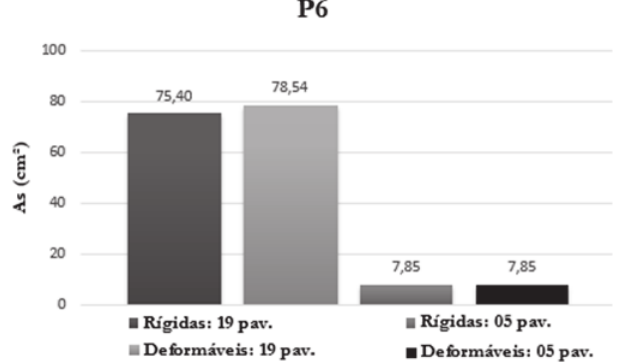
Figura 19 Modelo de Alva e El Debs [21]: armadura do pilar P3 da estrutura com 19 e 5 pavimentos, considerando ligações rígidas e ligações